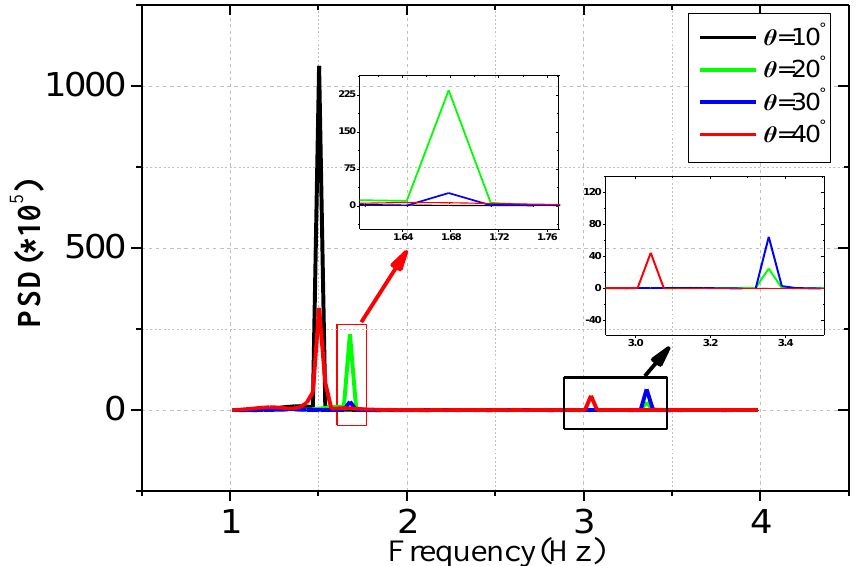
Figure 15. E ff ects of incidence angles of the square target on the power spectrum Figure 15. Effects of incidence angles of the square target on the power spectrum density.